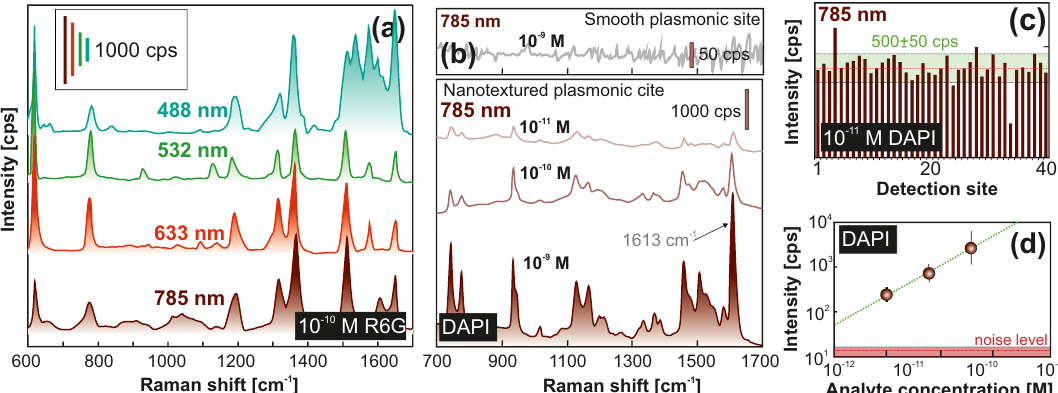
Figure 4. Surface-enhanced Raman scattering (SERS) performance of the fabricated device. ( a ) Series of SERS spectra measured from Rhodamine 6G (R6G) molecules deposited from a 5- µ L water drop (initial analyte concentration is 10 − 10 M) onto the central plasmonic element probed at different pump wavelengths. Corresponding wavelengths of laser source are indicated near each spectrum. ( b ) SERS spectra of 4 (cid:48) ,6-diamidino-2-phenylindole dihydrochloride (DAPI) molecules dissolved in distilled water at different concentrations and deposited on the sensor element. Representative SERS spectrum of 10 − 9 M DAPI obtained with a similar sensor with smooth central pillar (i.e., without laser-printed spallative craters) is shown at the top panel ( b ). Each provided SERS spectrum was averaged over 50 similar independent spectra obtained at various detection sites on the central pillar. Fixed pump intensity ( ≈ 0.9 mW/ µ m 2 ) and accumulation time (1 s) were used to obtain all spectra. ( c ) SERS intensity at 1613 cm − 1 measured at different detection sites on the central pillar from DAPI molecules deposited from a 5- µ L water droplet containing 10 − 11 M of analyte. The ± 10% deviation from the average intensity level is indicated by green-color area. ( d ) SERS intensity at 1613 cm − 1 versus DAPI